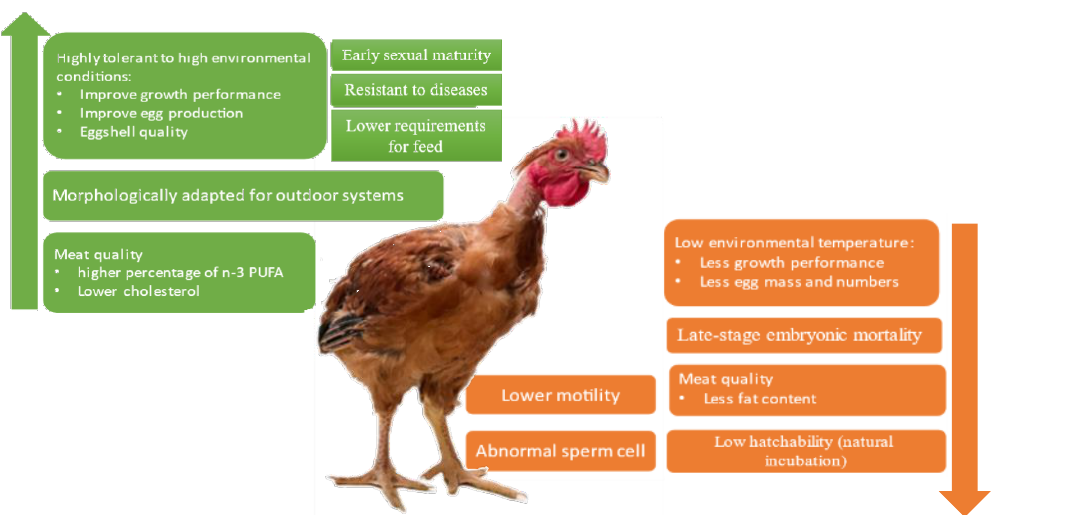
Figure 5. Summary of the advantages (green) and disadvantages (orange) of the naked neck gene in the different parameters and their possible productive implications.